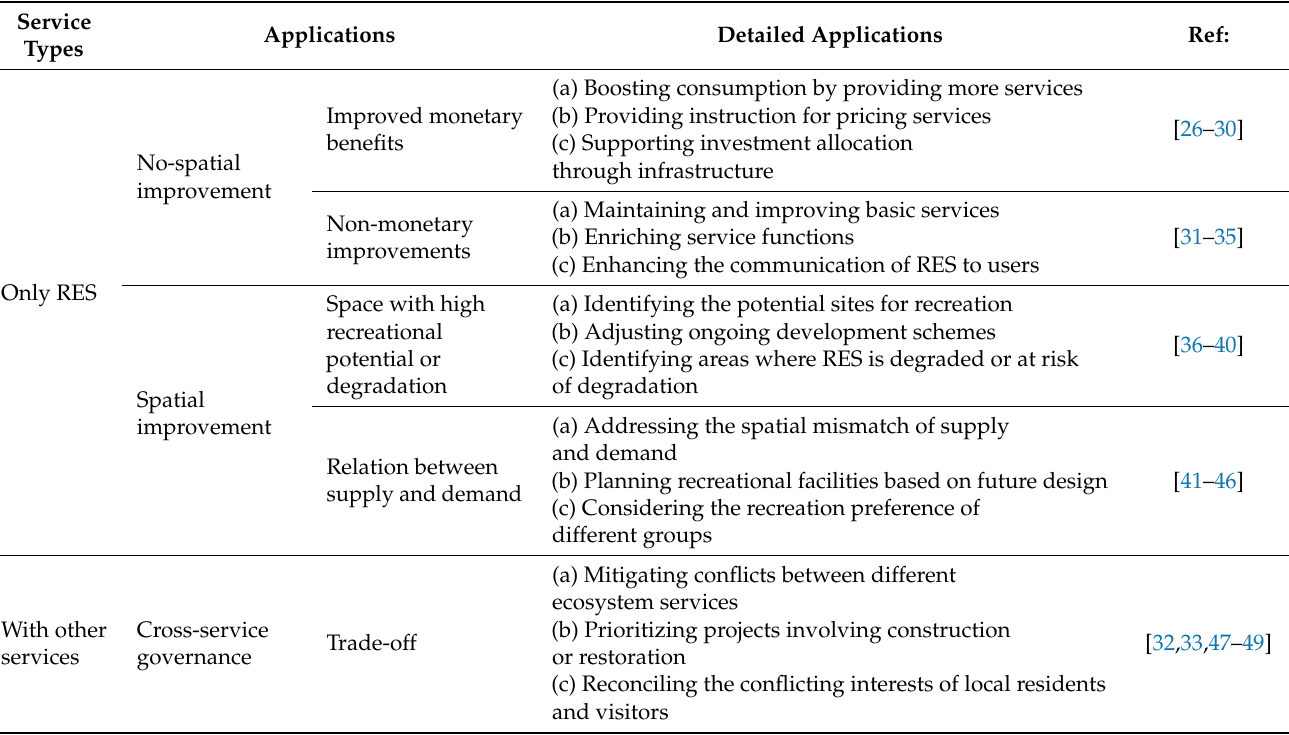
Figure 4. Multilayer Pie Chart of application and governance in RES. Table 3. Application of RES